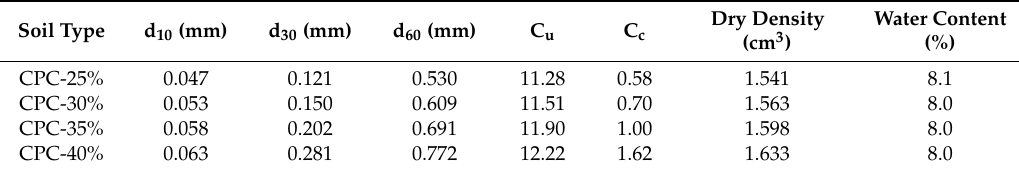
Table 4. Parameters of di ff erent coarse particle contents.